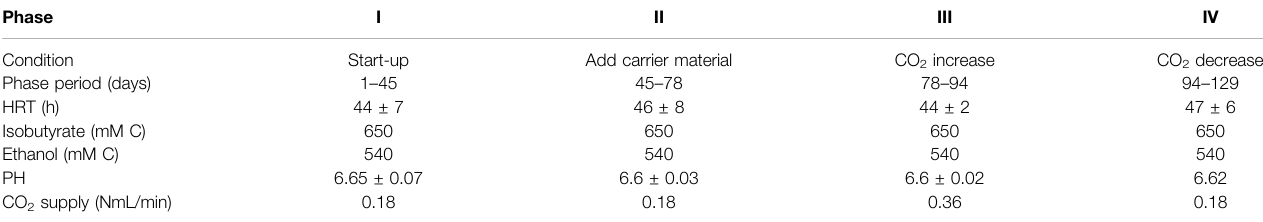
TABLE 1 | Overview over the different phases in the reactor. The in fl uent carbon sources, the steady state duration for each phase, the HRT, pH and CO2 supply are listed. Phase I